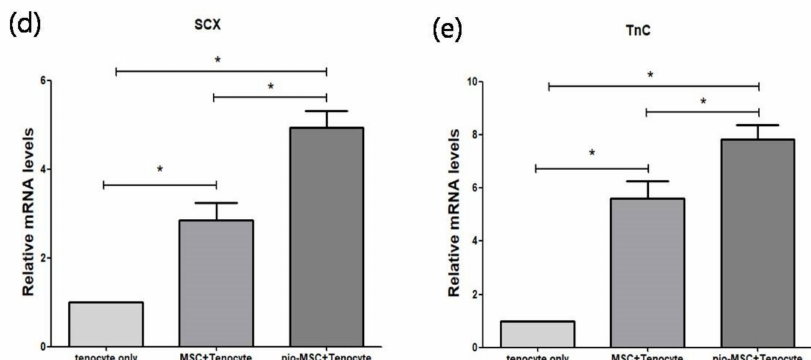
Figure 6. Comparison of the relative mRNA expression levels in co-cultures of tenocytes with MSCs or Pio-MSCs using an indirect transwell system. ( a ) Schematic model of the co-culture system used. Tenocytes were co-cultured with MSCs and Pio-MSCs and then subjected to qRT-PCR analysis for ( b ) collagen Type I, ( c ) collagen type III, ( d ) SCX, and ( e ) TnC. The expression levels in each case were normalized against those in the tenocyte only culture. All data are expressed as a mean ± standard error (SE) from five replicates. * p <